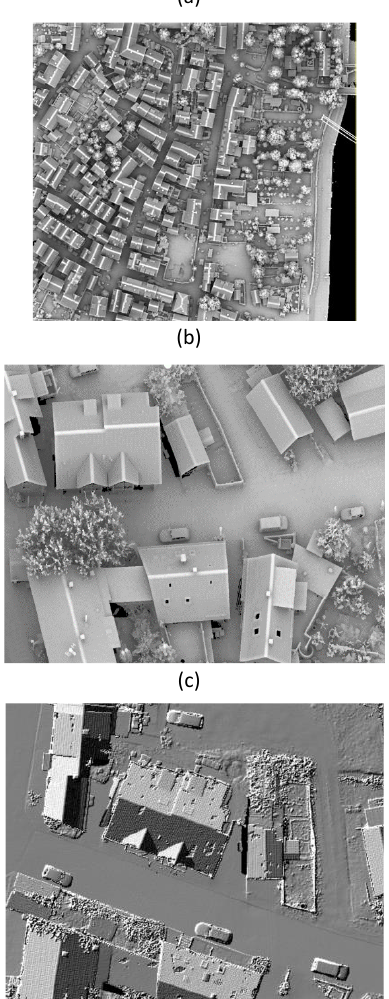
Figure 1. Test area Hessigheim: (a) overview of the 3D point cloud, (b) zoom-in 3D point cloud, (c) zoom-in 2D rasterized shading